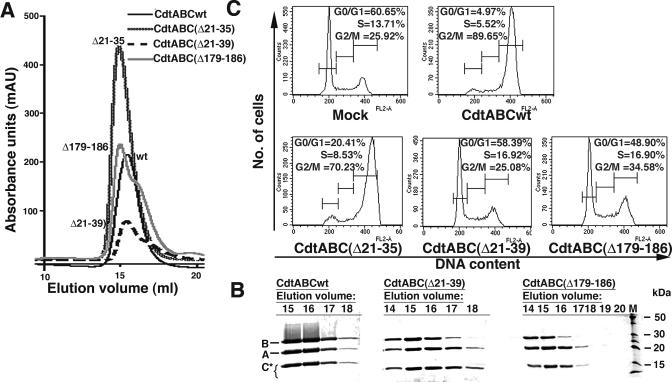
Effects of N- and C-Terminal Deletions of CdtC on Holotoxin Integrity and Toxicity(A) Size exclusion chromatography of recombinant holotoxin containing different CdtC mutants. After cation-exchange chromatography, 2-ml CDT holotoxin samples were injected onto a Superdex 200 HR 10/30 column and run at flow rate of 0.5 ml/min in 200 mM NaCl, 20 mM HEPES (pH 7.5), 2.5 mM DTT on an ÄKTA FPLC. Fractions of 1 ml were collected.(B) Following elution from the gel filtration column, several peak fractions were subjected to SDS-PAGE and CDT subunits visualized with Coomassie blue stain. A, CdtA; B, CdtB; C, cdtC; C*, deletion mutants of CdtC.(C) Cell cycle analysis of HeLa cells exposed to 1 ng/ml concentration of either wild-type or mutant holotoxin for 3 hr at 37 °C, 5% CO2. Cells were processed 48 hr after holotoxin treatment, and DNA content was measured by flow cytometry. The calculated percentages of cells in G0/G1, S, and G2/M are shown.